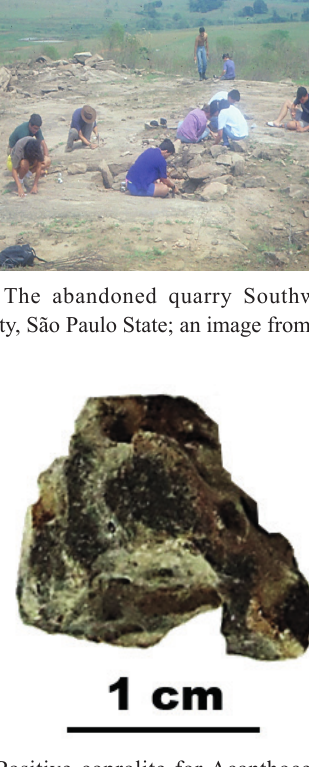
Figure 5 - Positive coprolite for Acanthocephala eggs in paleoparasitological examination from Crocodylomorpha host recovered in Santo Anastácio Municipally, São Paulo State,